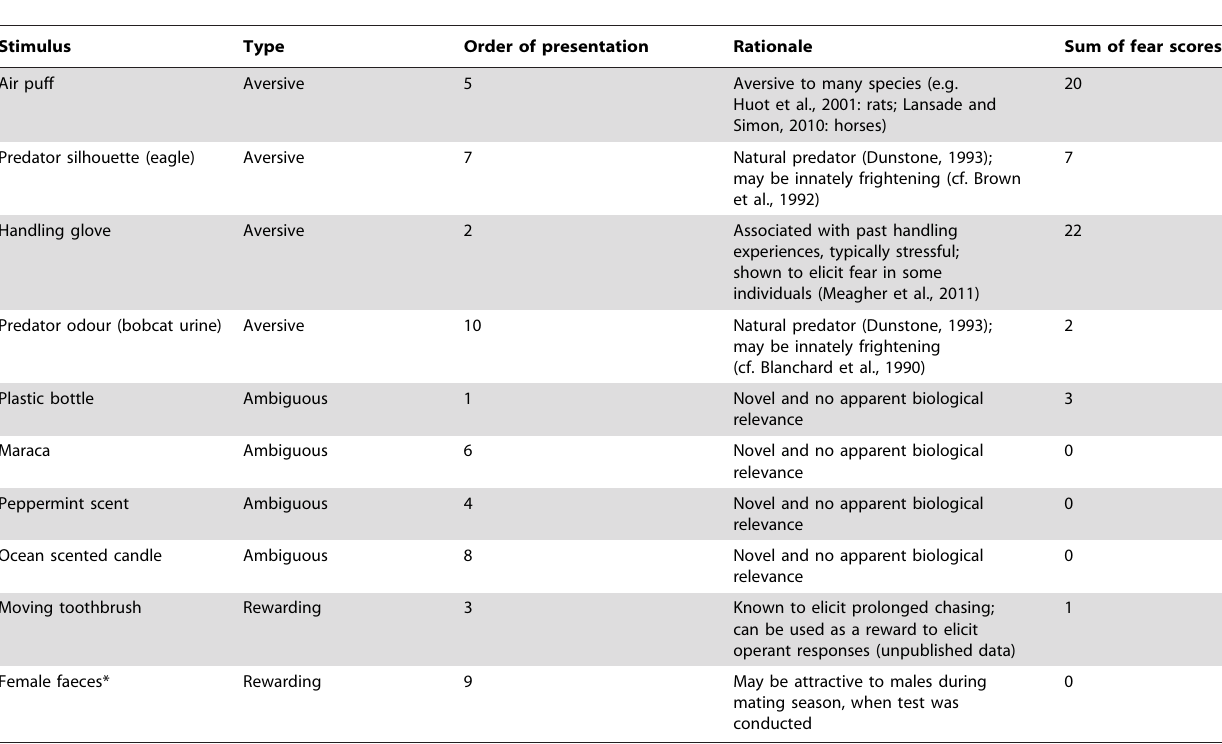
Table 2. Order in which stimuli were presented in investigatory behaviour tests, with validation of the categories to which they were